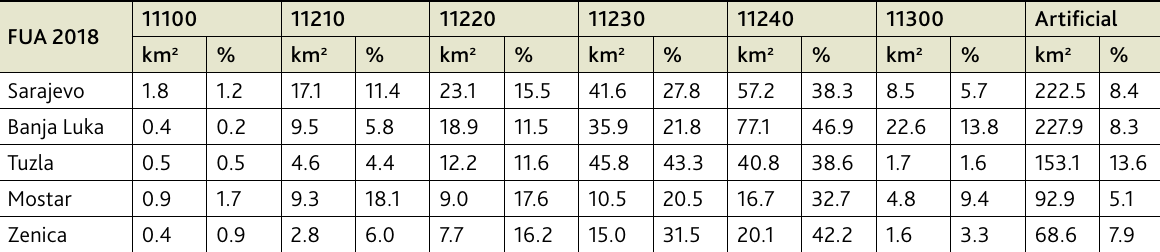
Table 5. Urban fabric subclasses distribution in